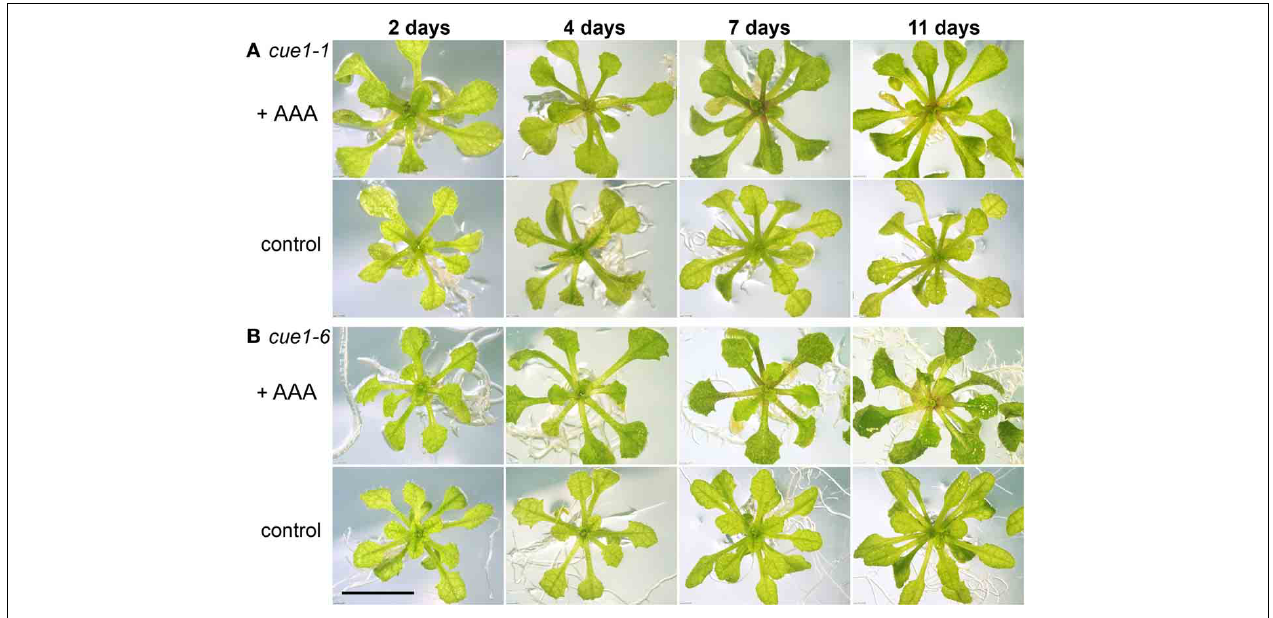
FIGURE 3 | Rescue of the reticulate leaf phenotype of cue1 . The alleles of cue1-1 (A) and cue1-6 (B) were fed with a cocktail of AAA. Four week old plants were grown on ½MS agar and then